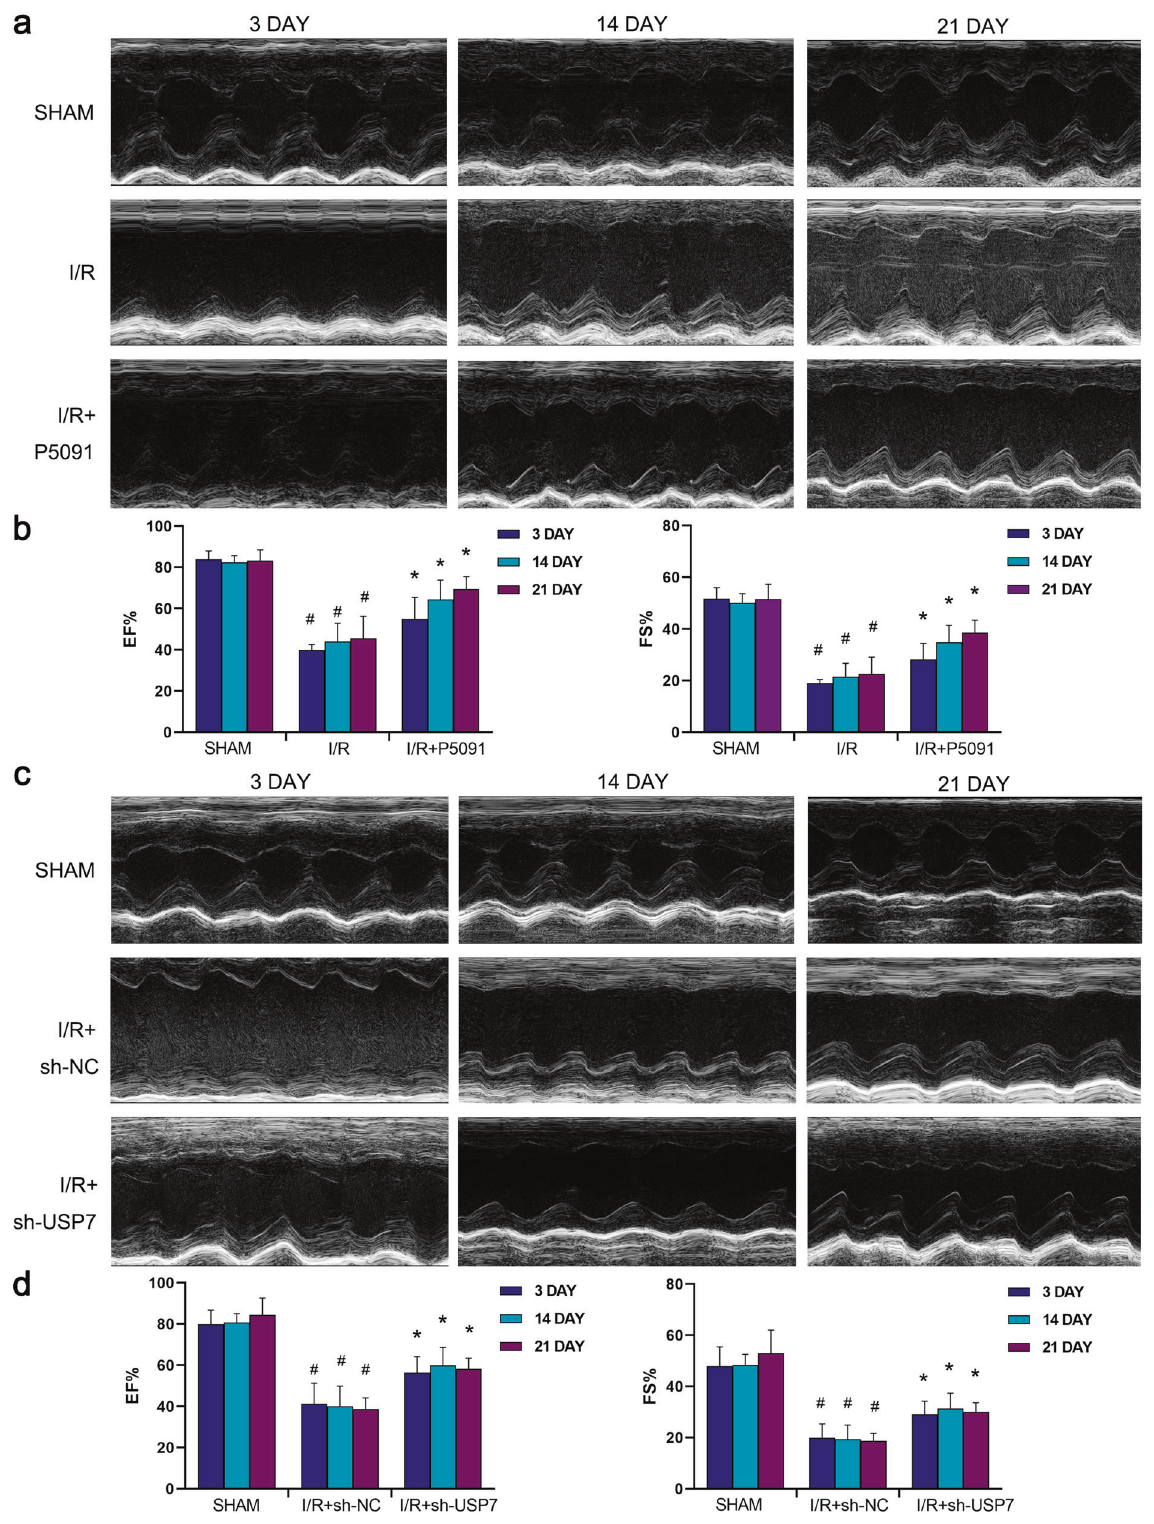
Fig. 4 Mice with cardiac dysfunction were treated by inhibiting USP7. a , b P5091 was intraperitoneally injected into mice for three consecutive days, and ultrasound Doppler was used to detect the EF% (ejection fraction) and FS% (fraction shortening) 3, 4, and 21 days after the operation. c , d sh-USP7 was injected into the myocardium of mice, and ultrasound Doppler was used to detect the EF and FS 3, 4, and 21 days after the operation. # Compared with the SHAM group, *Compared with the I/R group, P < 0.05, mean ± standard deviation ( n =